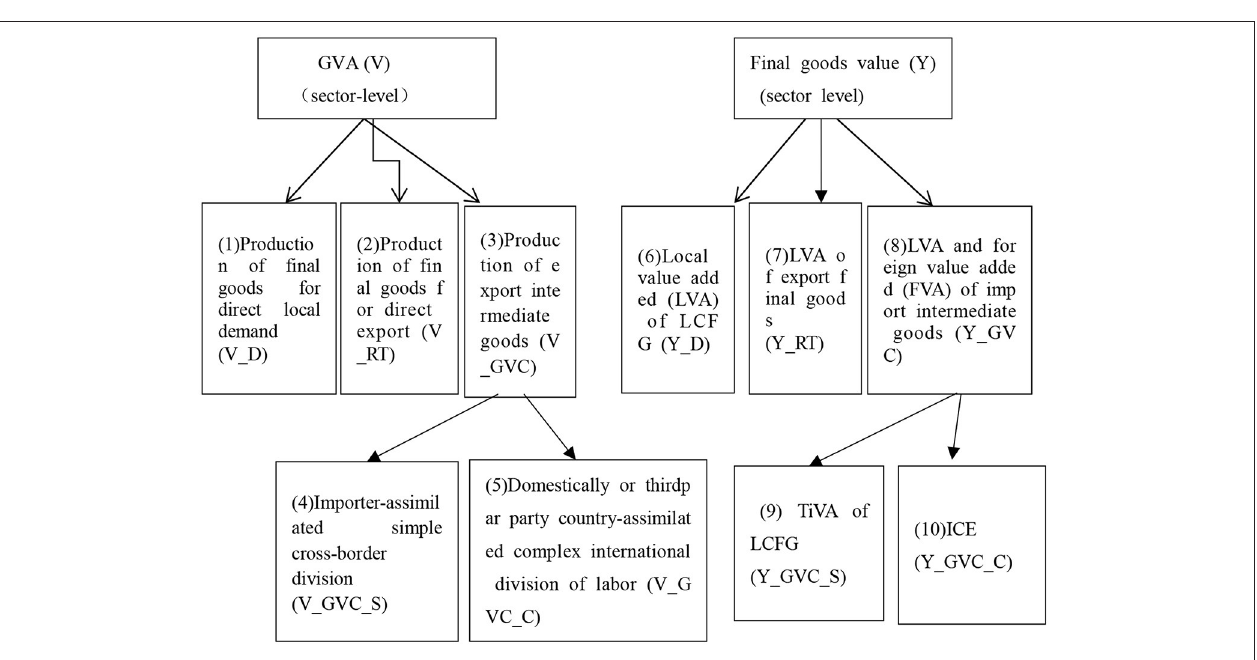
shorter, more scattered and more localized, which makes